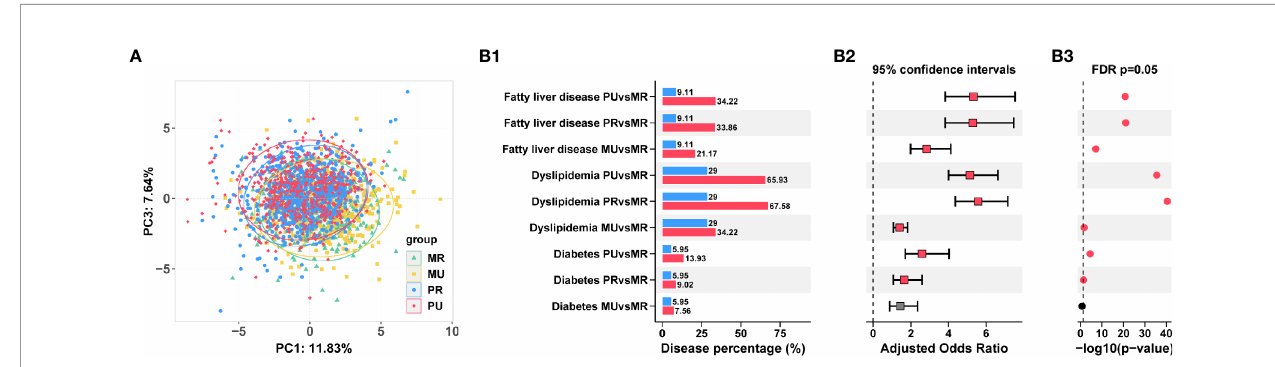
FIGURE 2 | Prevalence of chronic diseases in the epidemiological investigation among the four groups in Ningxia Province China. (A) Separation of clinical variables among the MR, MU, PR, and PU groups revealed by Principal component analysis (PCA). (B) Prevalence of diabetes, dyslipidemia, and fatty liver disease in the four groups (B1) . The adjusted Odds ratios (B2) and FDR adjusted p-values were also shown (B3)